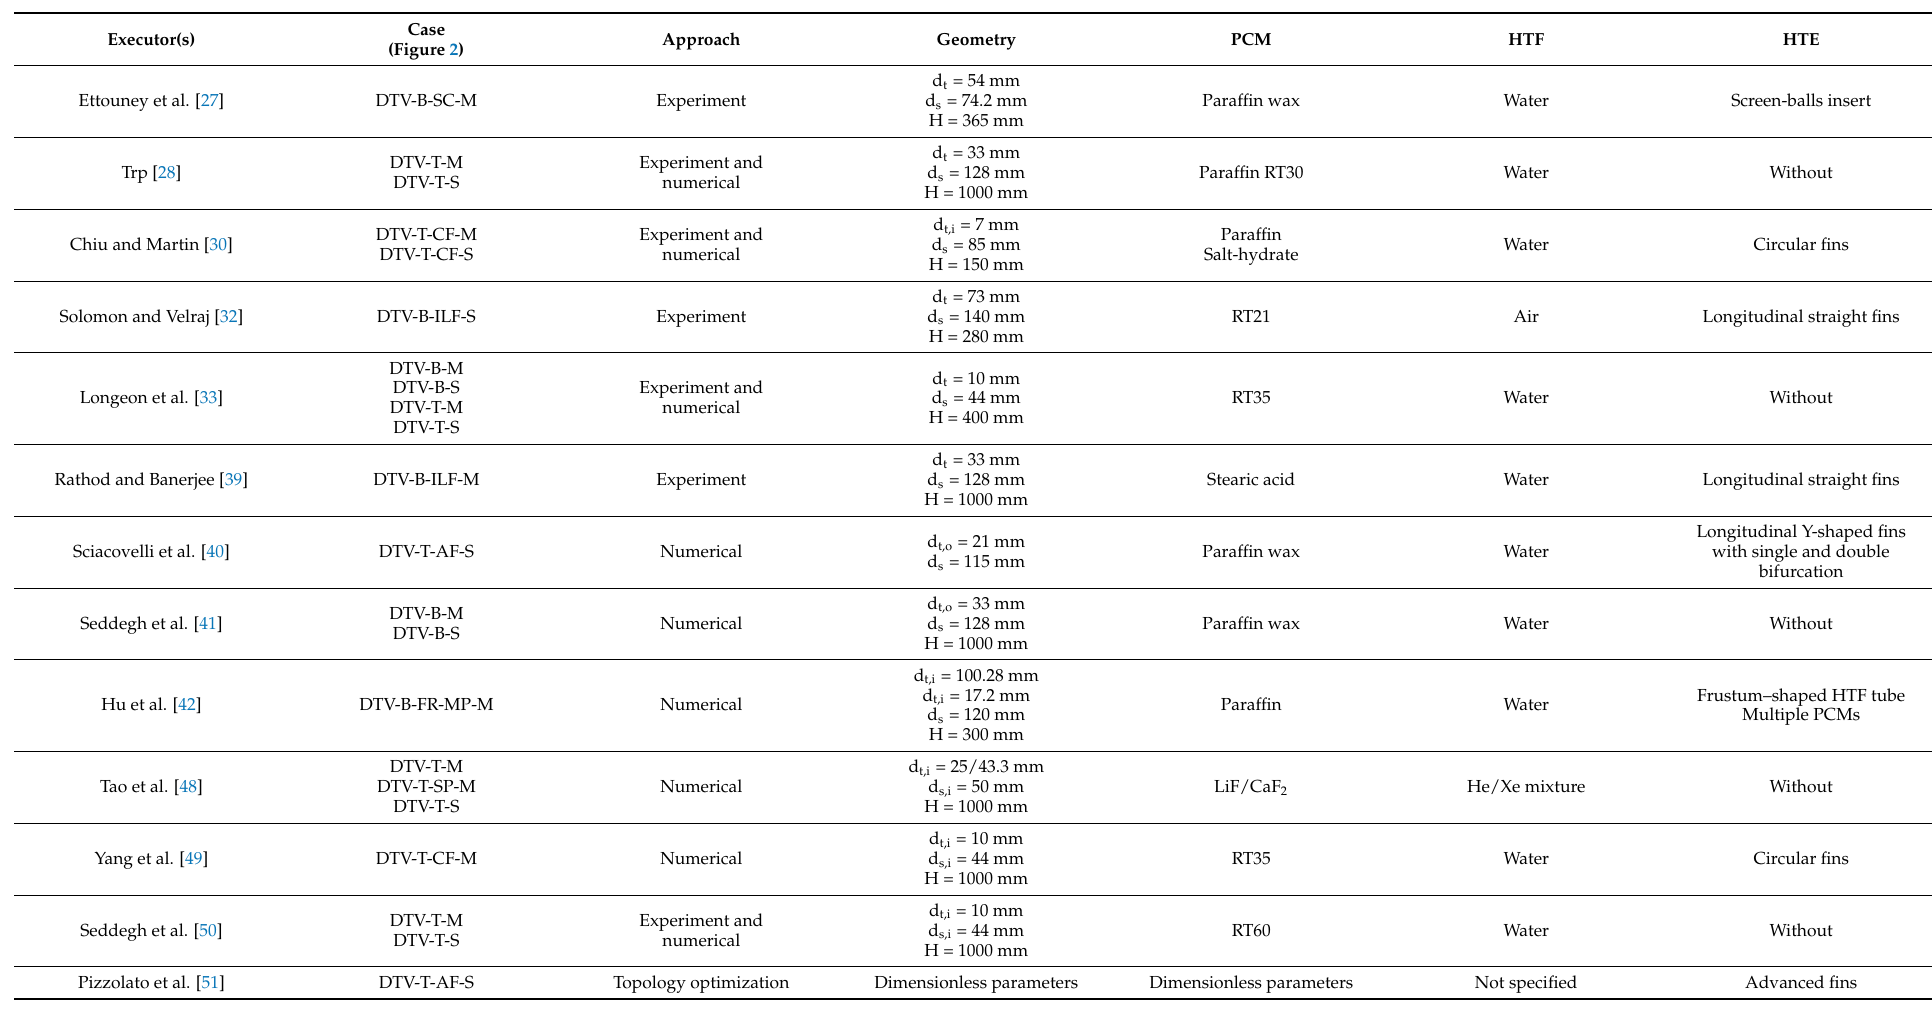
Table 2. Studies dealing with vertical double-tube